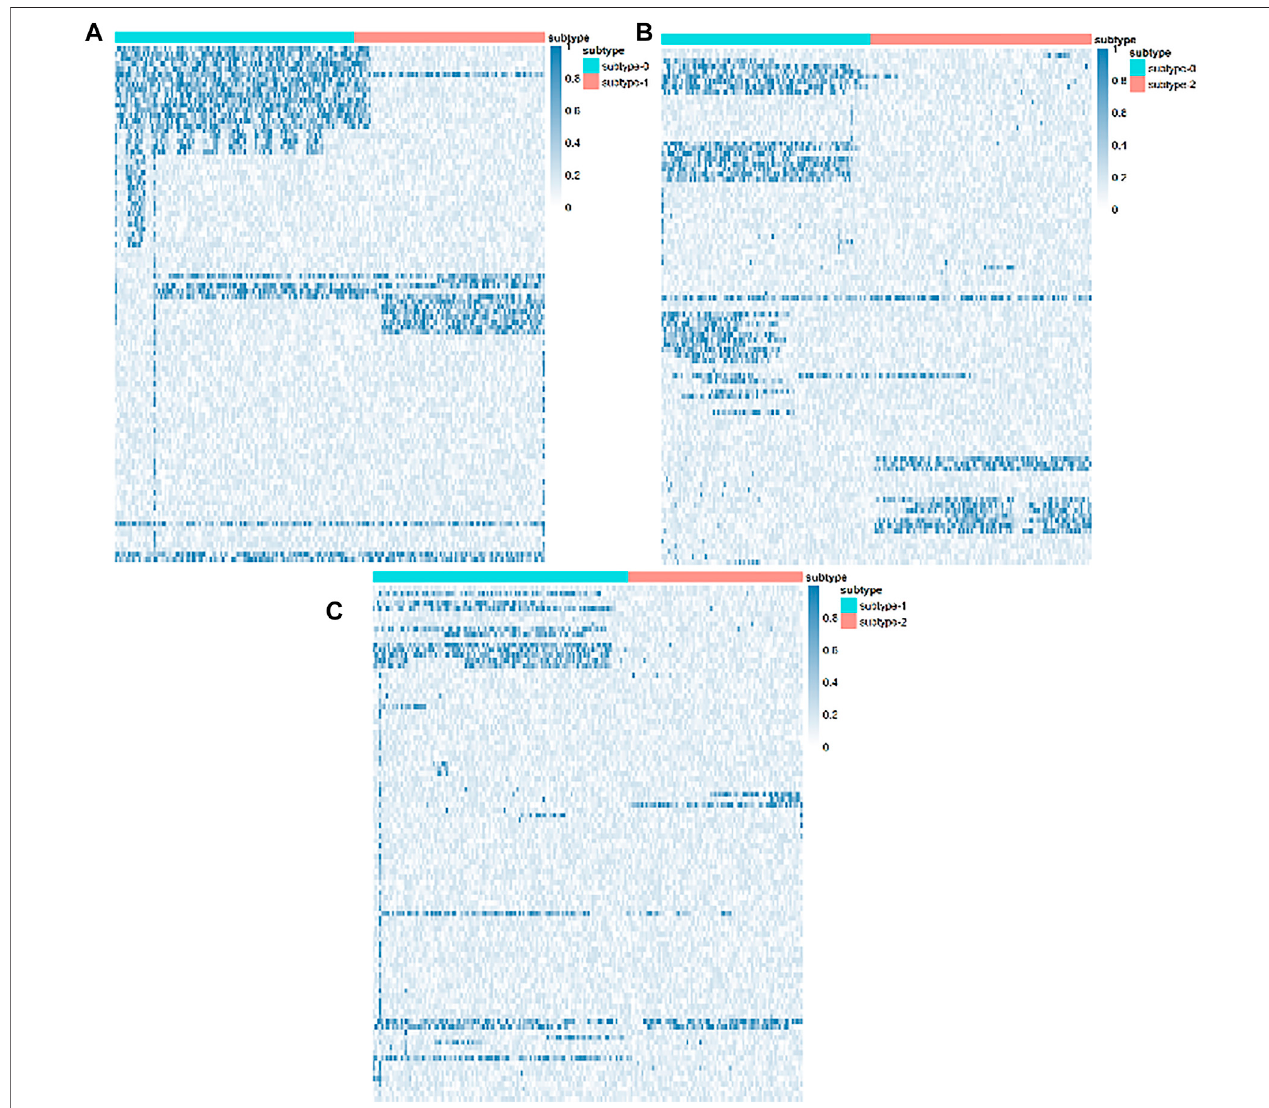
FIGURE 4 | Differentially expressed mRNAs of the LUCS subtypes. (A) Subtype 0 and subtype 1. (B) Subtype 0 and subtype 2. (C) Subtype 1 and subtype 2.